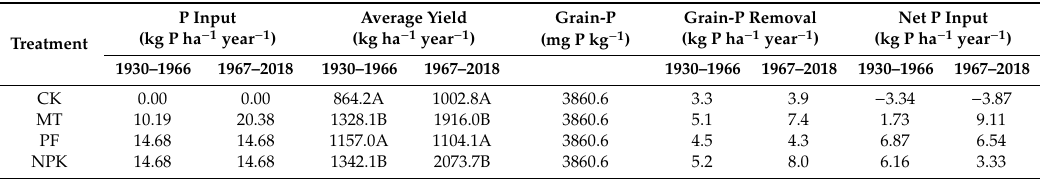
Table 2. Input and output of phosphorus (P) to the system under various fertilizer treatments.